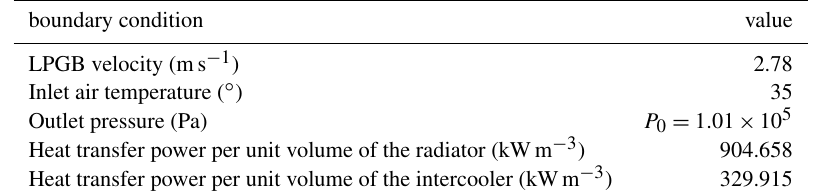
Figure 5. Comprehensive structural design. Table 1. The boundary conditions of an LPGB’s internal and external flow fields.